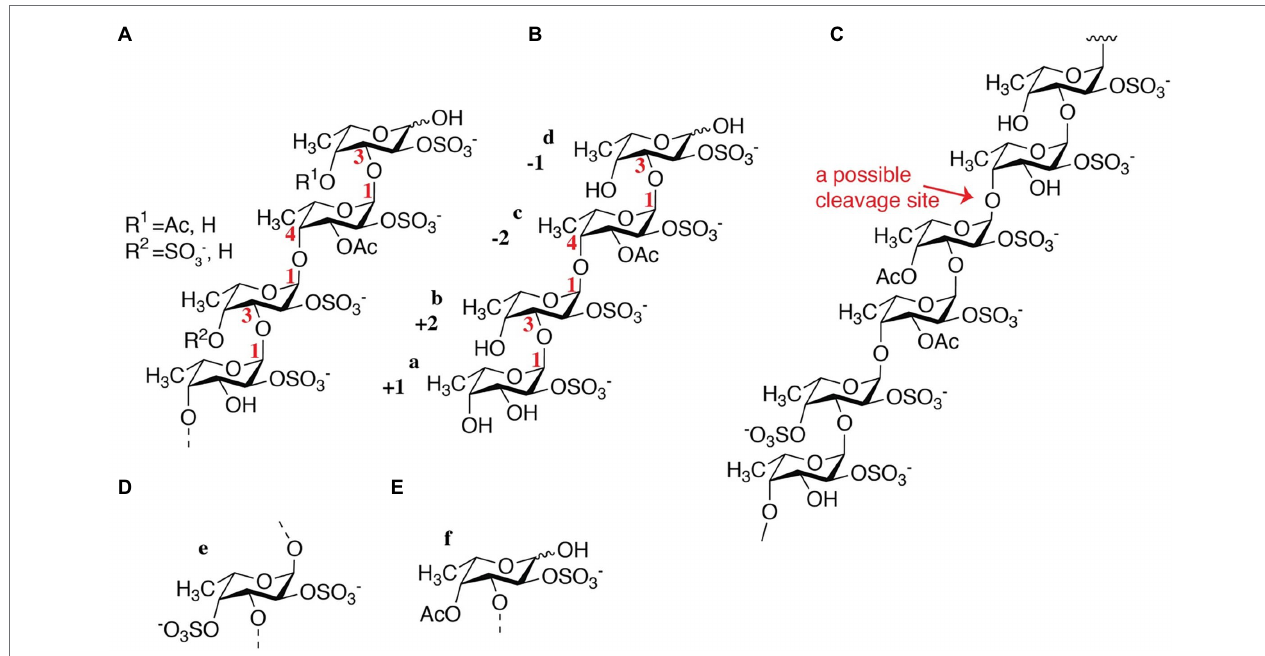
FIGURE 9 | Chemical fine-structures of the LMWF oligosaccharides released by Fhf2 Δ 484 from fucoidan from F. evanescens . (A) General molecular structure containing 2-sulfated residues along 2-sulfated/3-acetylated, 2-sulfated/4-acetylated and 2-,4-disulfated residues; (B) Molecular structure of a main product; (C) Molecular structure of the substrate indicating the endo-1,4 cleavage site that can tolerate acetylated fucosyl units in the − 1 position and 2,4-disulfated fucosyl units nearby; (D) 2,4-disulfated fucose occurs to some degree at non-terminal sites and (E) 2-sulfated and 4 acetylated fucose occurs to some degree at the reducing end.